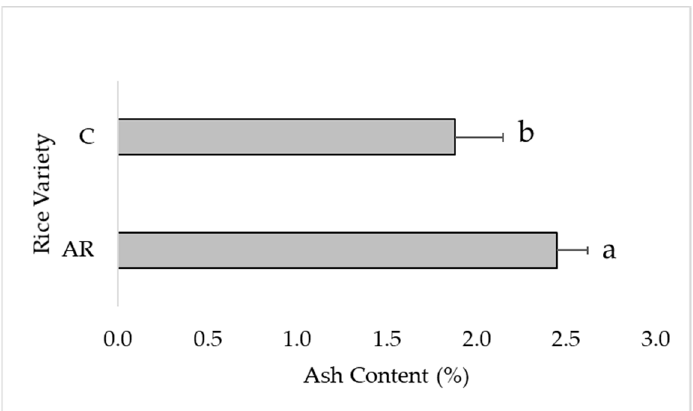
Figure 1. Average values (%) ± standard deviation ( n = 4) of ash content in the refined flours of Oryza sativa L. varieties Ariete and Ceres at harvesting. Letters a and b indicate significant differences among varieties ( p ≤ 0.05).